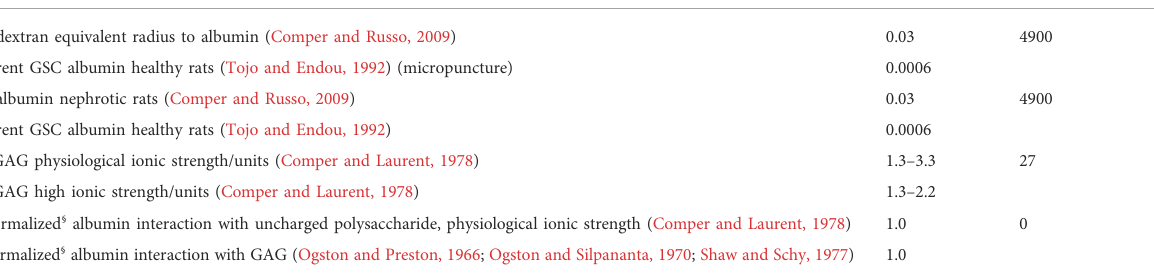
TABLE 2 Simpli fi ed representative data to calculate the percent change of different parameters possibly affecting the glomerular sieving coef fi cient (GSC) of